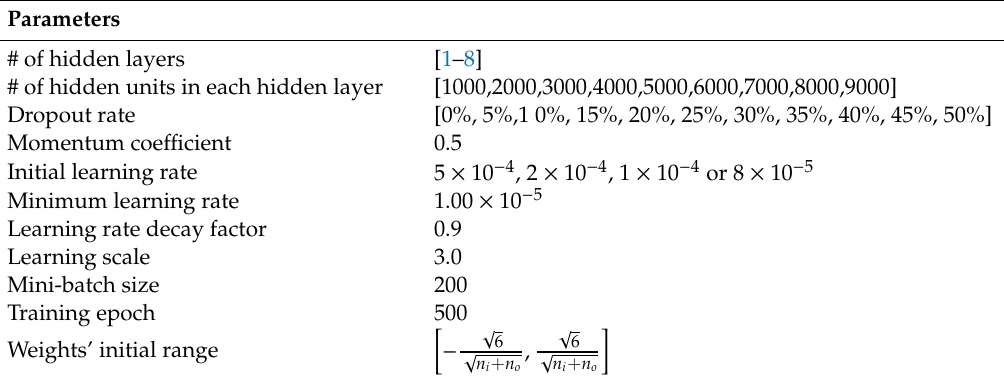
Table 1. Detailed parameter configurations for D-GPM.